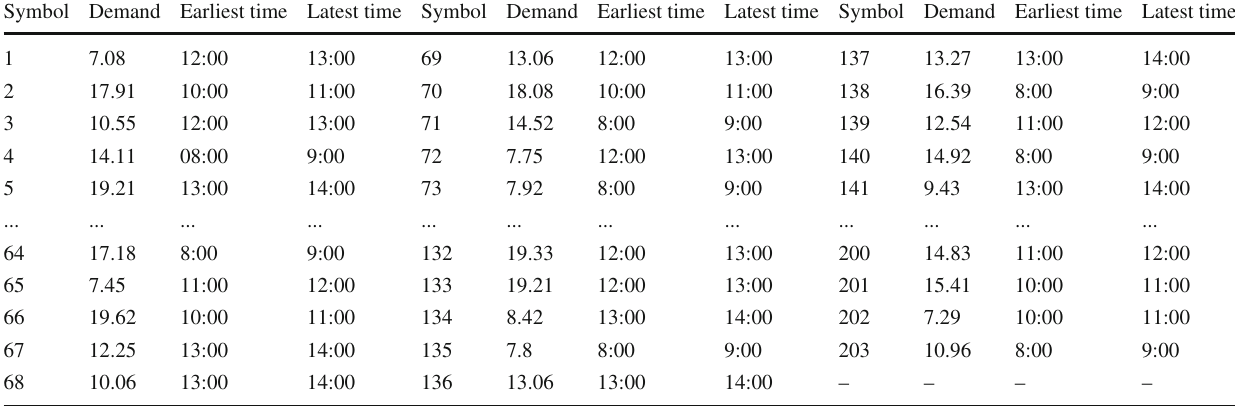
Table 2 Customer’s demand and distribution time